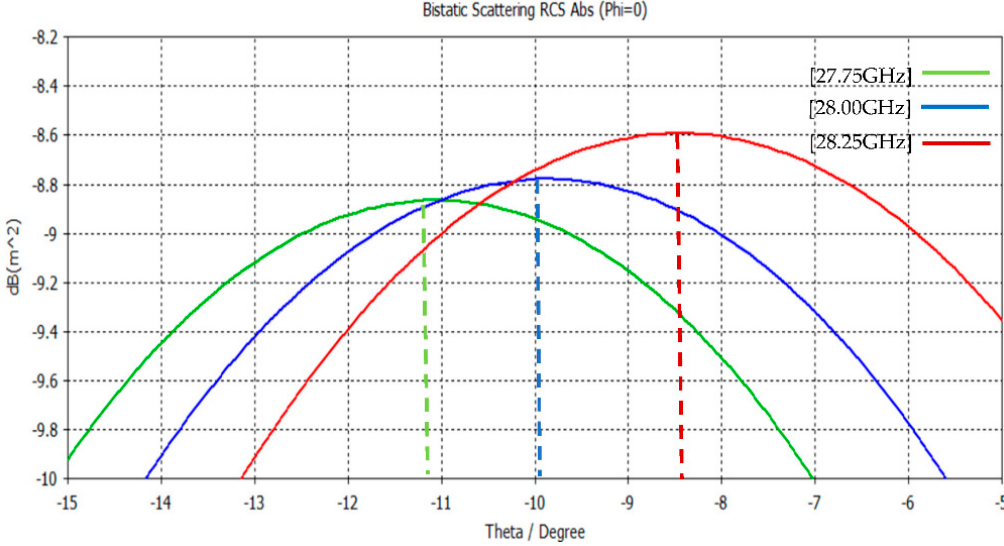
Figure 9. Results of bandwidth for beam steering 10° at 28 GHz in the one-stripe configuration.